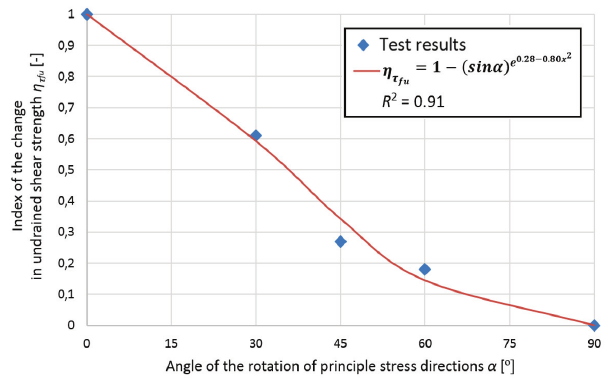
Fig. 3. Relationship describing the index of change in the undrained shear strength for clay